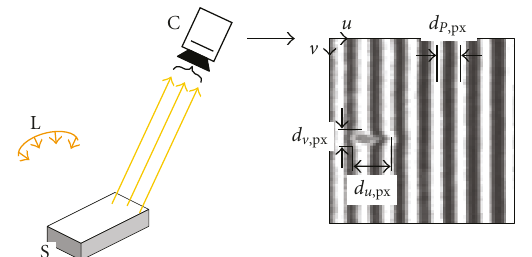
Figure 1: Surface inspection principle for specular objects. The illumination L projects a structured pattern, which is reflected by the inspected surface S and then projected/recorded by a camera C . The generated stripe image depicts a periodical bright and dark stripe structure of period d P , px whose disturbances are synonymous of defective parts. The illumination technique must be defined in such a way that all relevant defects are visually